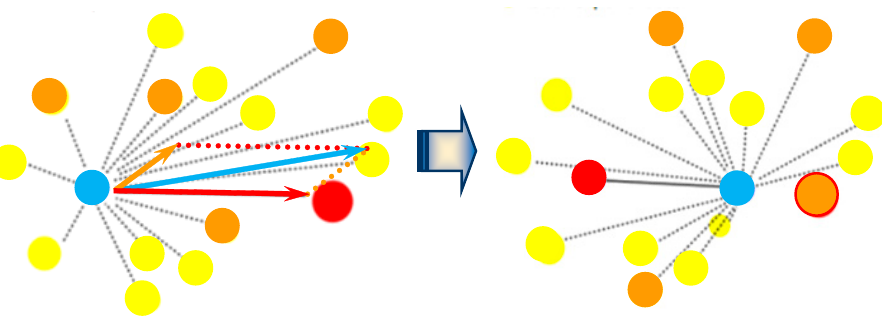
Figure 9. Principle of the Firefly Algorithm. The perceived light attractiveness depends on the brilliance of the casting beetle. The brighter a firefly, the more fireflies it attracts. The current firefly is motivated to fly towards the shiniest one along the arrow in red (see the left side of Figure 9). Nevertheless, while tracking the target, our firefly can perceive lights from other fireflies, especially from the shinier ones, which constitute attraction points as well. Hence, the other fireflies in the swarm, especially the ones in orange, could disturb the flight along the direction colored in orange as well. By composing the two directions (in red and in orange), the final direction, in blue, is taken by the current firefly. Meanwhile, the swarm moves to new positions and changes light intensities, as suggested in the right side of Figure 9. It is possible